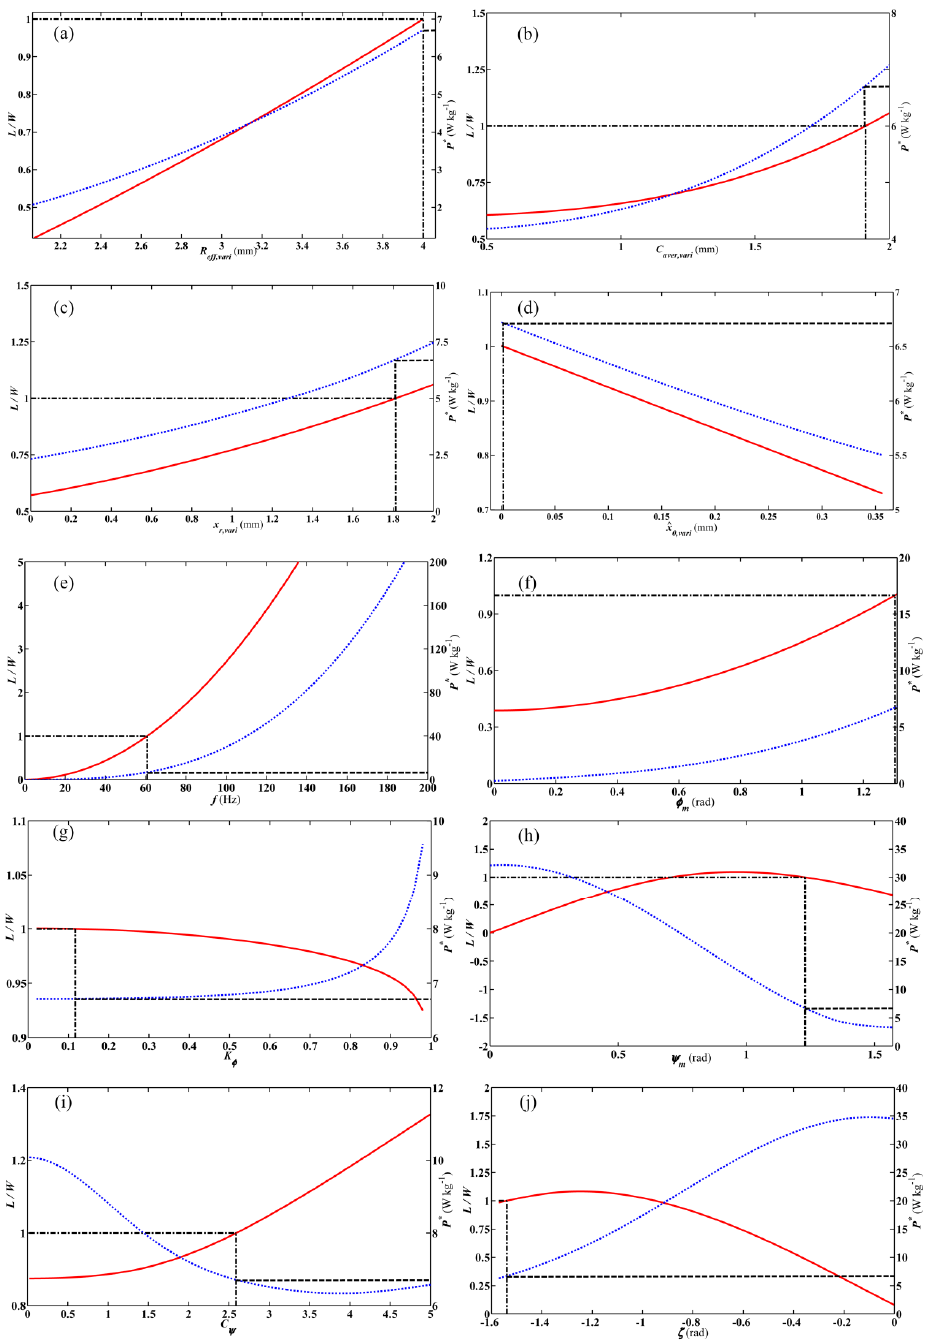
Figure 12. ( a – j ) Single ‐ parameter sensitivity analyses for combined optimal WGP and WKP. The layout is identical to Figure 8.